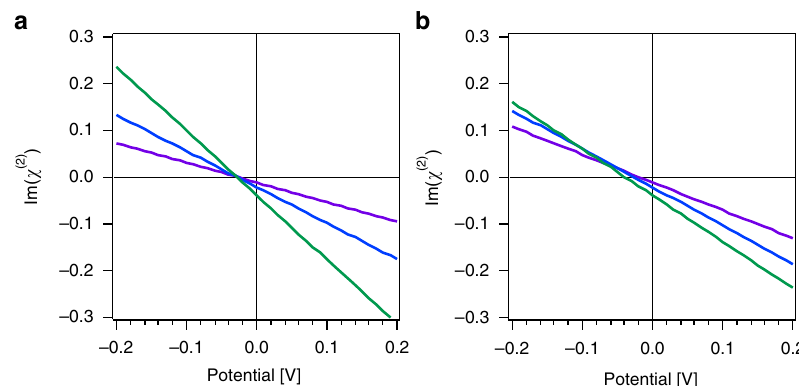
Fig. 6 Potential-dependent offsets. Imaginary part of the SFG response at 3000 (purple), 3100 (blue), and 3200 (green) cm − 1 for three oscillators on a surface simulated using the parameters from Fig. 5 as a function of interfacial potential, ϕ (0), calculated without a and with b